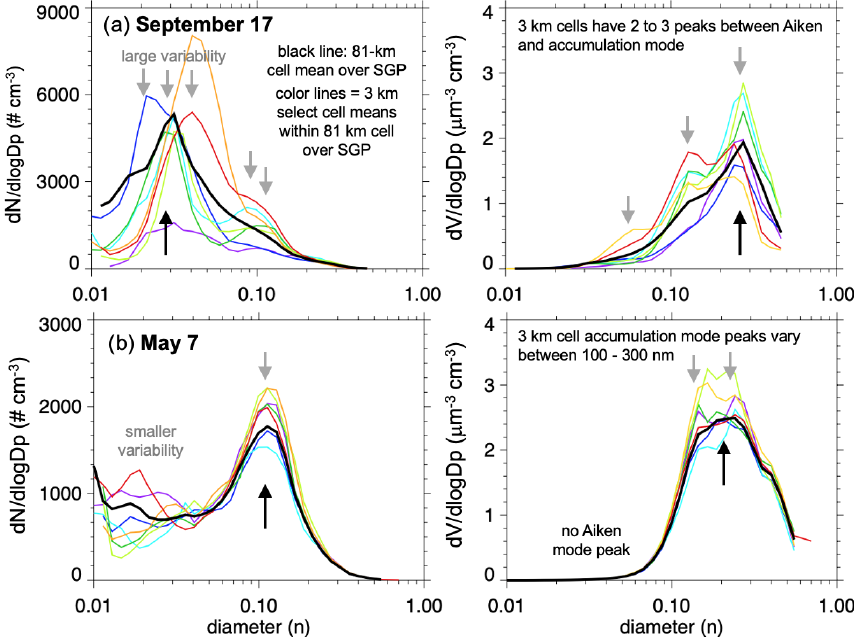
Figure 9. Aerosol number and volume size distributions on (a) 17 September and (b) 7 May. Black line denotes the average within the 81km cell over the SGP site, and the color lines denote select 3km cell averages within the same 81km